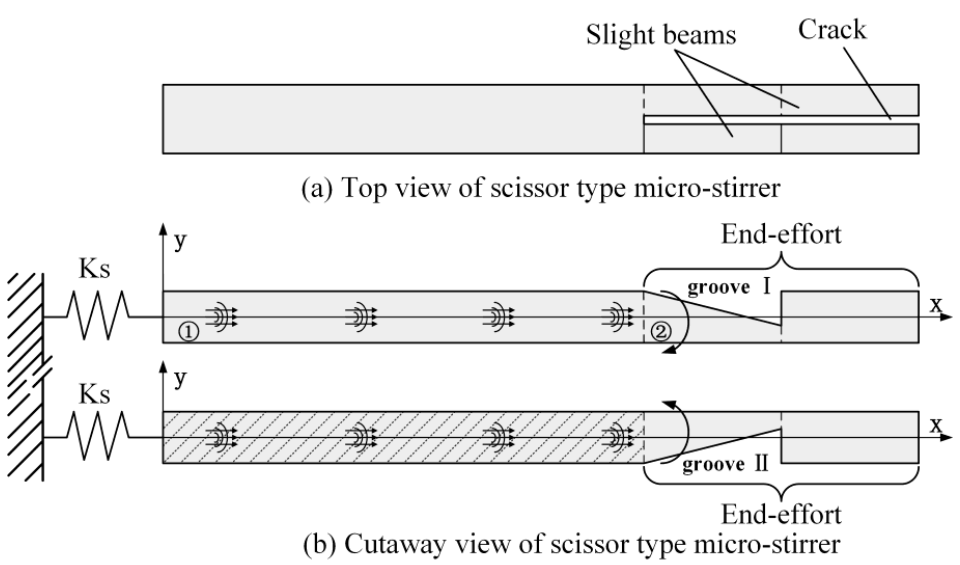
Figure 3. Theoretical model of scissor-type micro-stirrer ① Longitudinal driven force, ② Bending moment at the reflective groove.